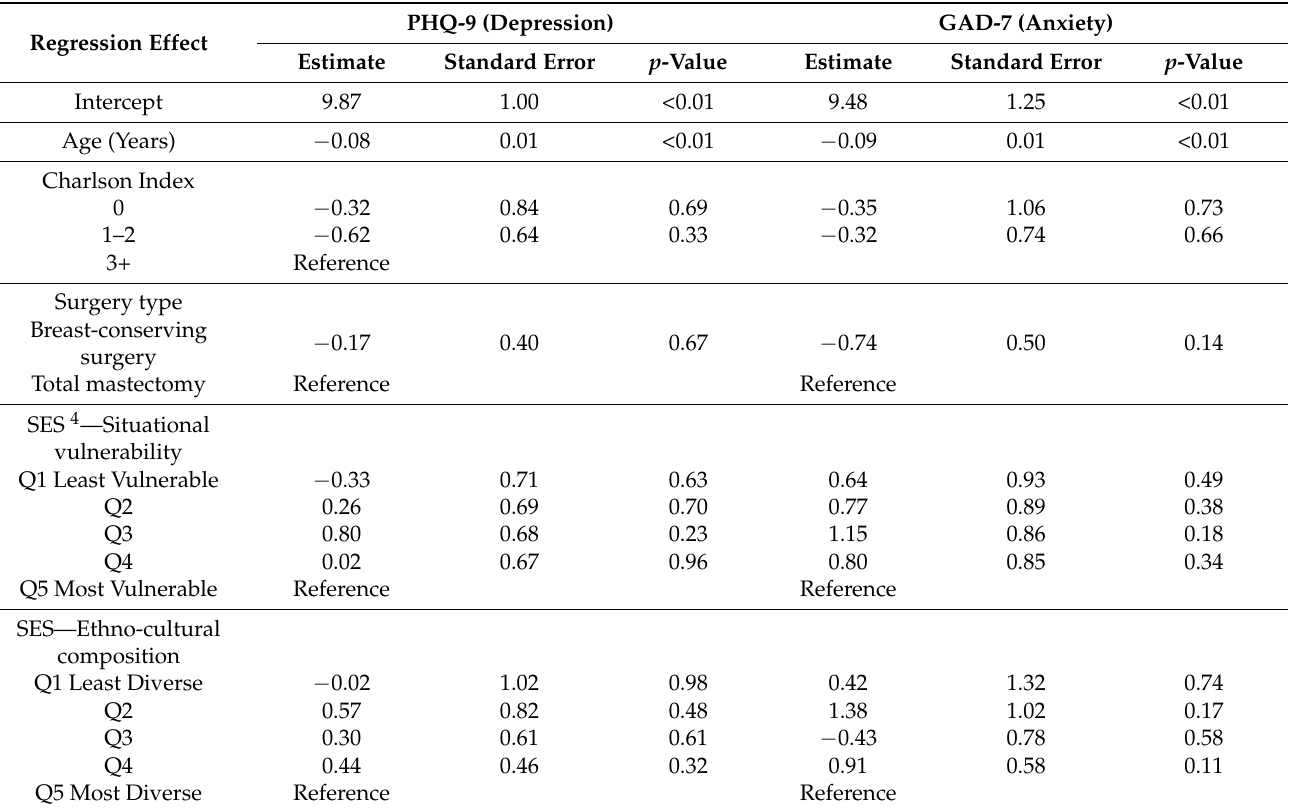
Table 5 outlines the results of the Breast-Q TM measure. Similar to results from the PHQ-9, GAD-7 and EQ5D BCS patients report better psychosocial and physical well-being than TM patients and also report better preoperative satisfaction with their